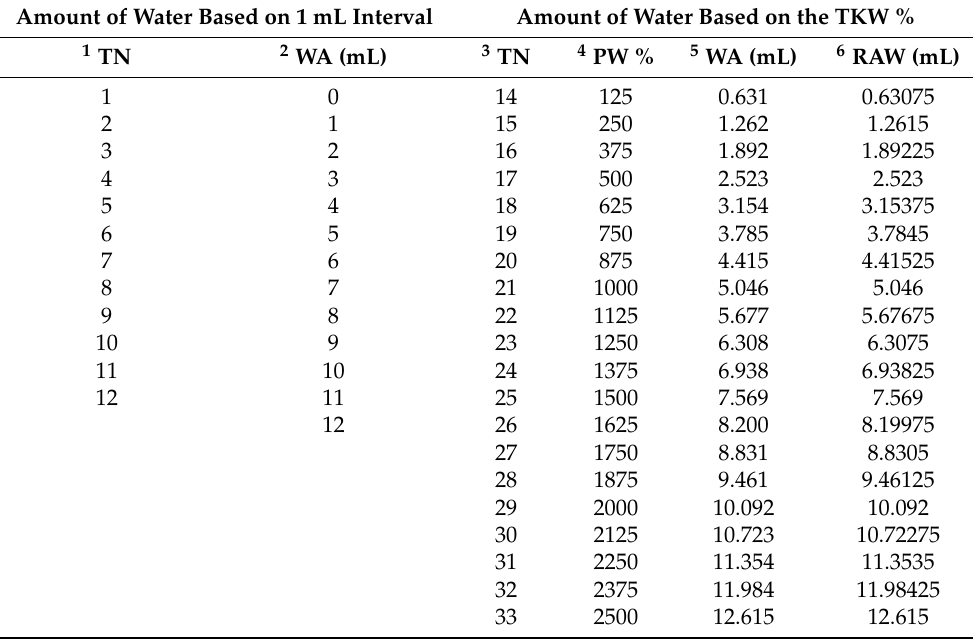
Table 1. The water levels based on the milliliter intervals of the bases and TKW%. Amount of Water Based on 1 mL Interval Amount of Water Based on the TKW % 1